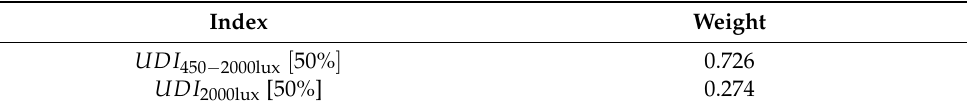
Table 7. The weights of UDI 450 − 2000lux [50%] and UDI 2000lux [50%] in the open-plan office room.